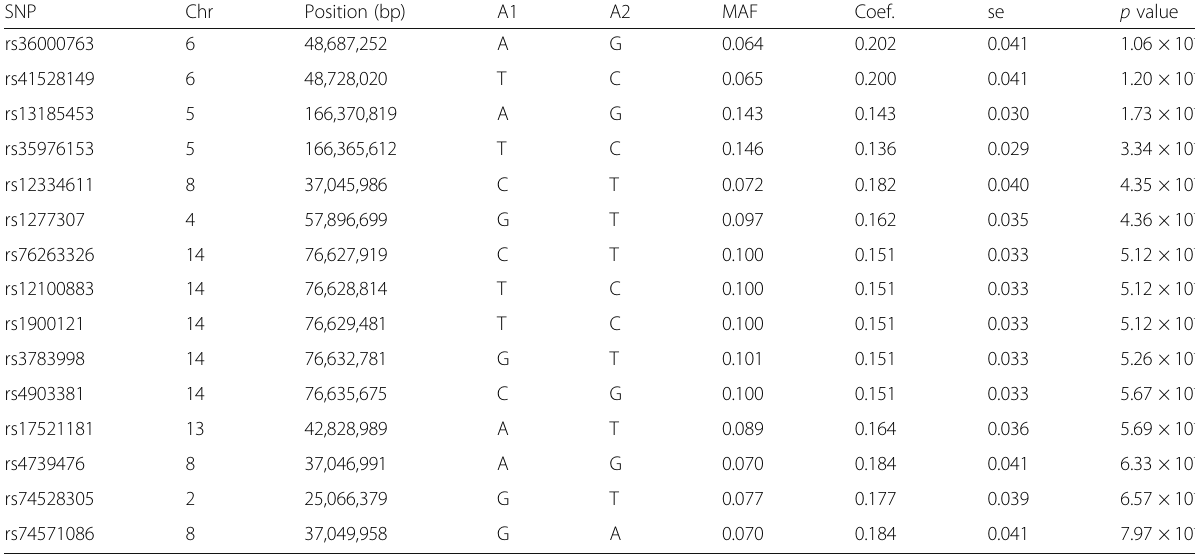
Results from the association between SNPs and ANGPTL3 level at baseline A1 and A2 the minor and major alleles, bp basepair, Chr chromosome, Coef estimated association coefficient, MAF minor allele frequency, se standard error, SNP single nucleotide